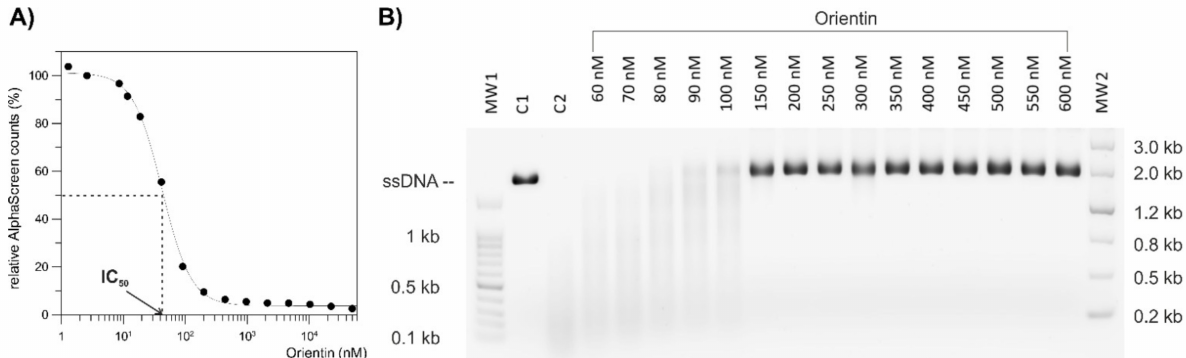
Figure 2. ( A ) Titration curve of orientin using the AlphaScreen assay, revealing an IC 50 value of 42 nM. ( B ) Inhibition of endonuclease activity by orientin, documented by a gel-based endonuclease inhibitory assay. The single-stranded circular DNA M13mp18 was used as substrate (lane C1). The substrate fully cleaved by endonuclease in the absence of inhibitor (lane C2) was used as a control. The GelPilot 100 bp Plus Ladder molecular weight marker (lane MW1) and the GelPilot Wide Range Ladder molecular weight marker (lane MW2) are shown for